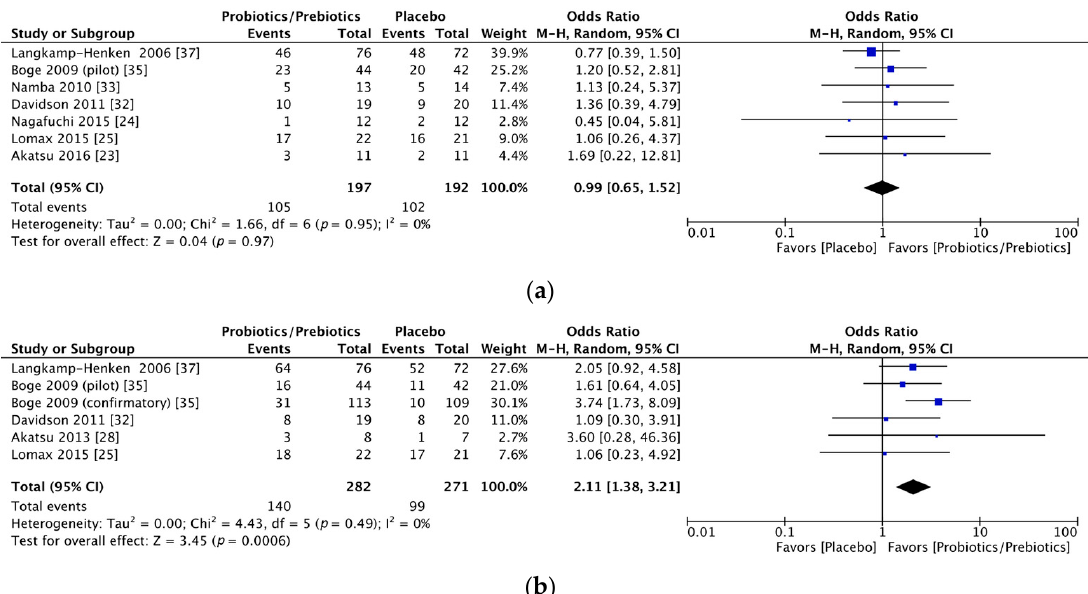
Figure 4. Forest plots of seroprotection and seroconversion rate of B strain. ( a ) Forest plot of seroprotection rate of B strain; ( b ) Forest plot of seroconversion rate of B strain. The bold data represents total participants of all included studies and the Odds ratio (OR) between the probiotics/prebiotics group and the placebo group. The diamond stands for the pooled OR. Weights are from random-effects model. CI: confidence interval.